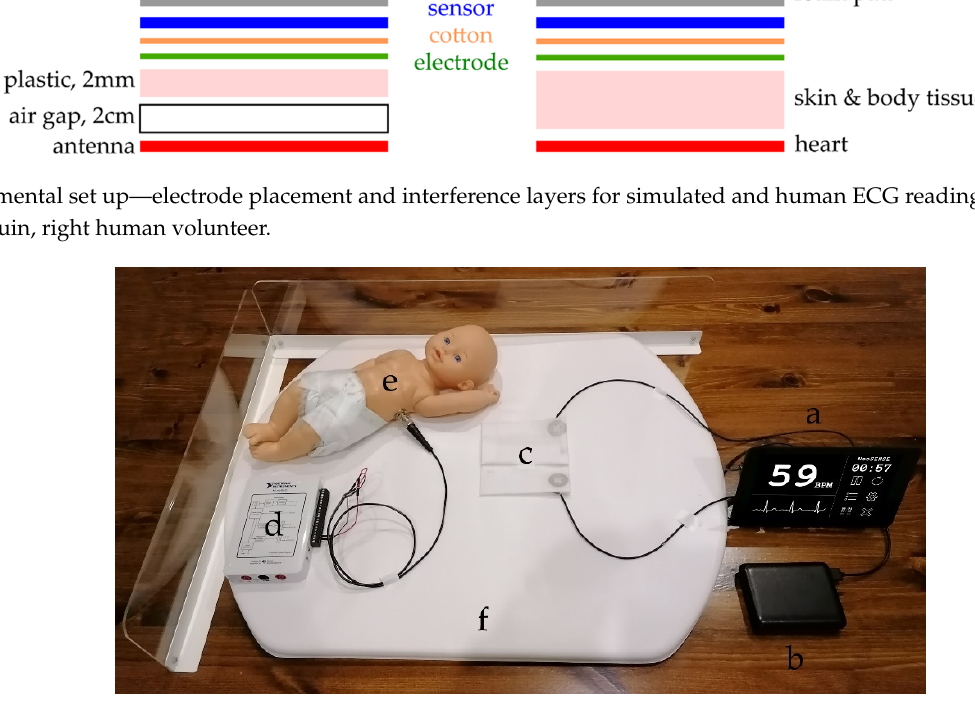
Figure 11. 5 s segments of a simulated ECG signal for ( a ) baseline copper electrodes; ( b ) conductive polymer ink; ( c ) con- ductive textile fabric. Analysis of a single beat and power spectral density (PSD) of the recorded signals is presented in Figure 12: